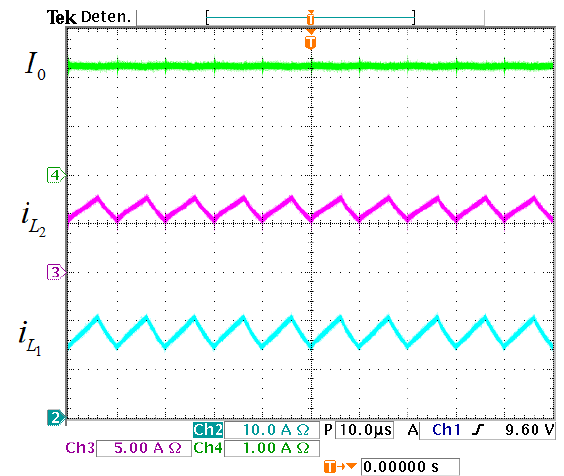
Figure 19. Current waveforms of the prototype. (From top to bottom) Load current I 0 (1 A/div),